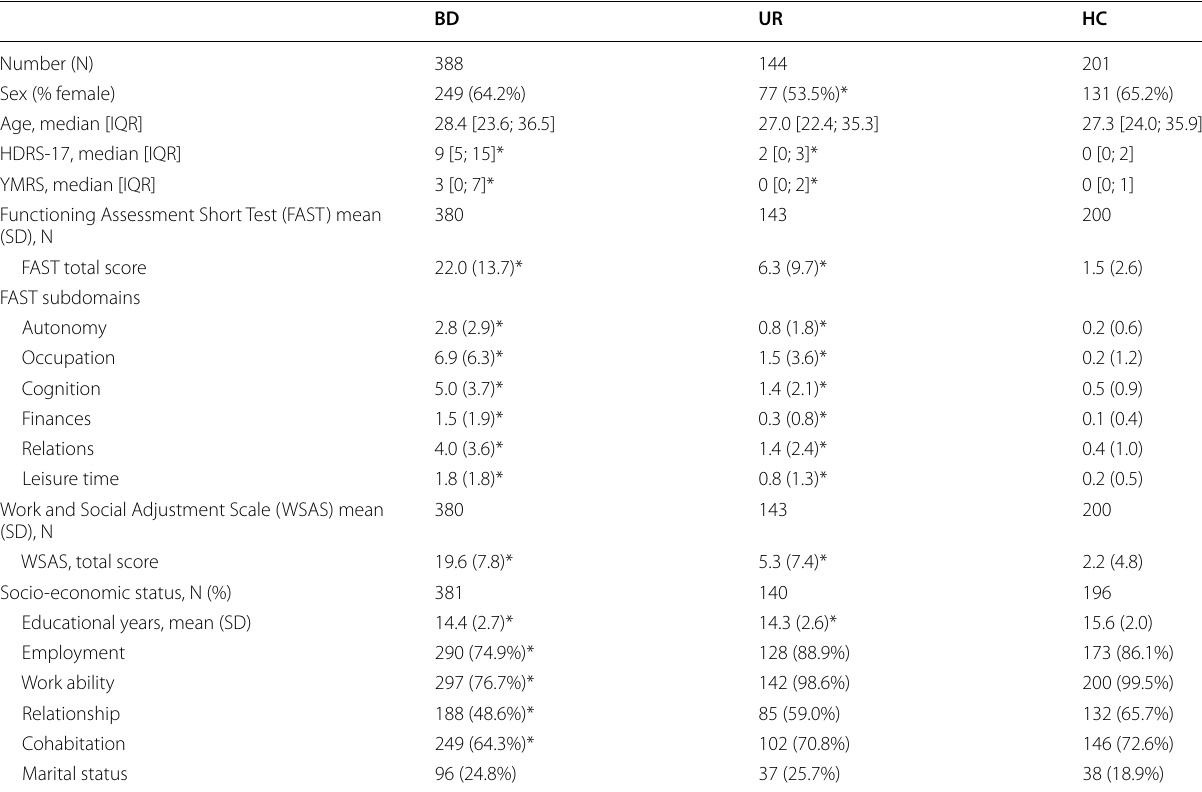
Table 1 Clinical, functional and socio-economic outcomes in patients newly diagnosed with bipolar disorder (BD), their unaffected first-degree relatives (UR) and healthy control individuals